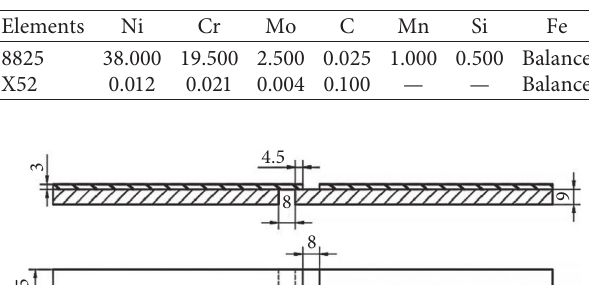
Table 1: Chemical composition of nickel-based alloy and carbon steel (wt. %).